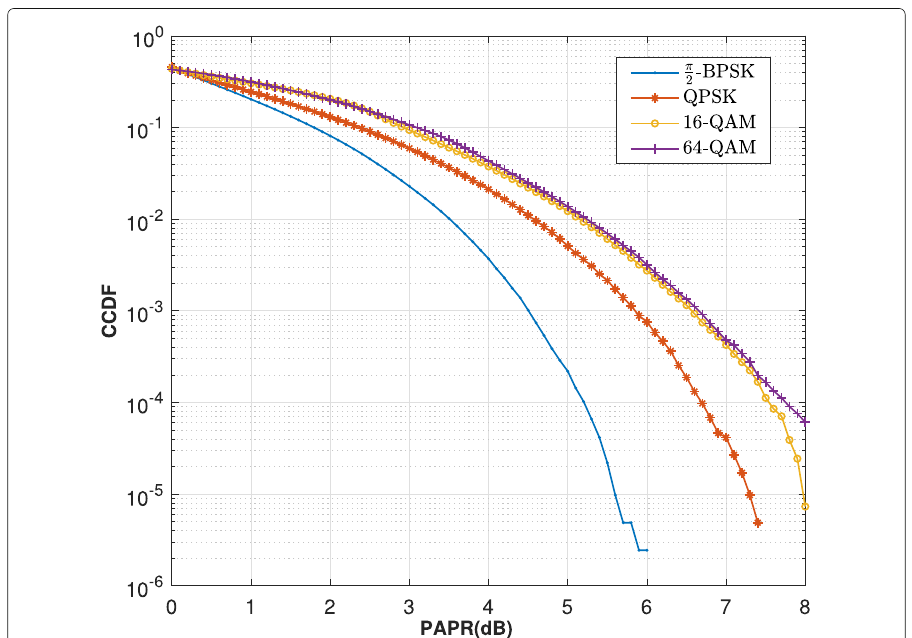
Fig. 1 PAPR of different modulation schemes using a DFT-s-OFDM